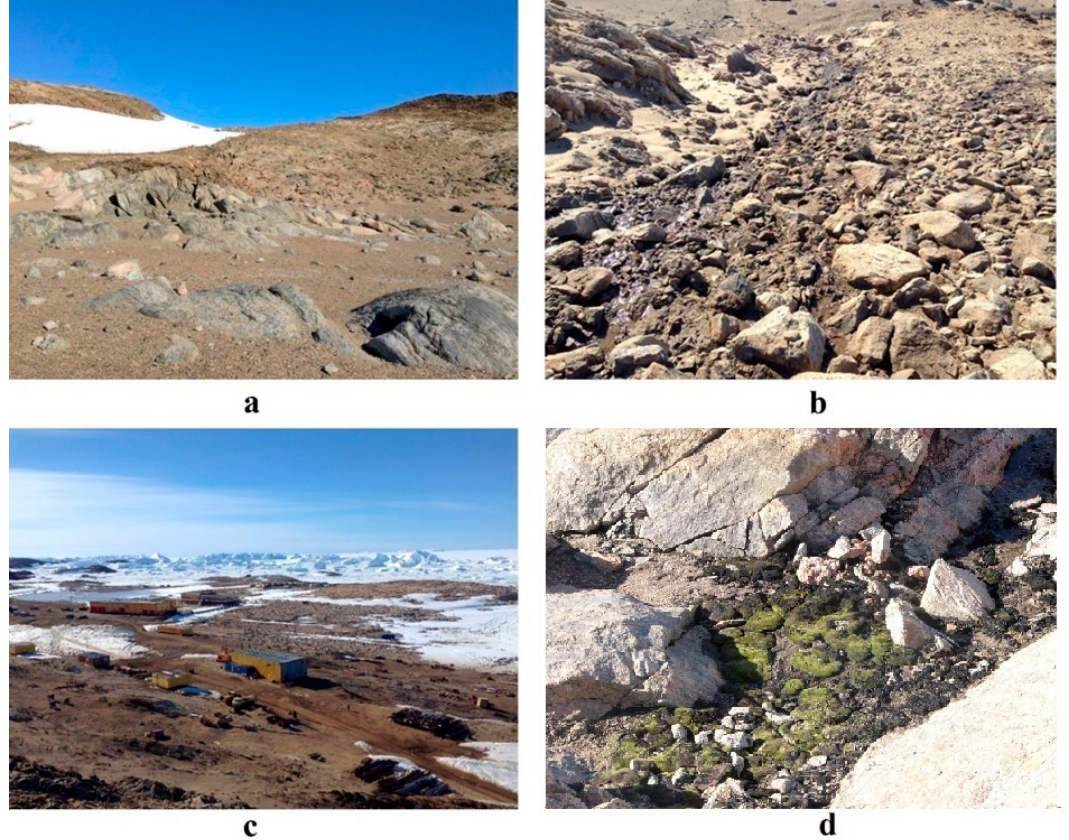
Figure 2. Landscape diversity of Larsemann Hills. ( a )—Larsemann Hills (high flank with dry conditions); ( b )—Larsemann Hills (valley bottom with meltwater flow); ( c )—Larsemann Hills (view on the Progress Station); ( d )—Larsemann Hills (wind shelter on the